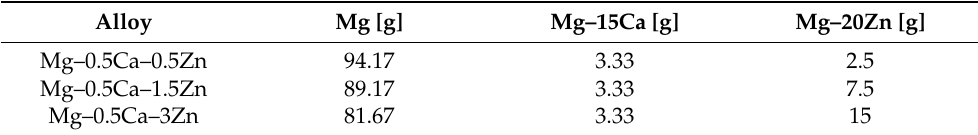
Table 1. Calculation of the metallic load for the experimental alloys Mg–0.5Ca–xZn.